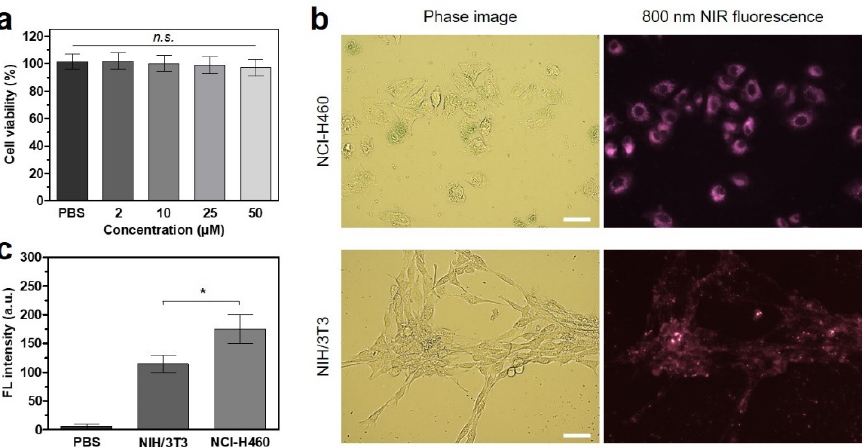
Figure 3. ( a ) Cytocompatibility assay of ZW800-AM using the NCI-H460 cell line. The percentage of cytotoxicity versus concentration is determined at 24 h post-treatment of ZW800-AM in the range of 2–50 μ M concentrations. ( b ) Live cell imaging of ZW800-AM in NCI-H460 and NIH/3T3 cells. Phase and NIR fluorescence images of each cell line are representative ( n = 3) and monitored at 24 h post-treatment with 20 μ M ZW800-AM. All NIR fluorescence images have identical exposure times and normalization. Scale bar = 100 μ m. ( c ) Relative fluorescence intensities in NCI-H460 and NIH/3T3 cells at 24 h post-treatment with 20 μ M ZW800-AM. Data are expressed as mean ± S.D. ( n = 3). * p < 0.05; n.s. = not significant.